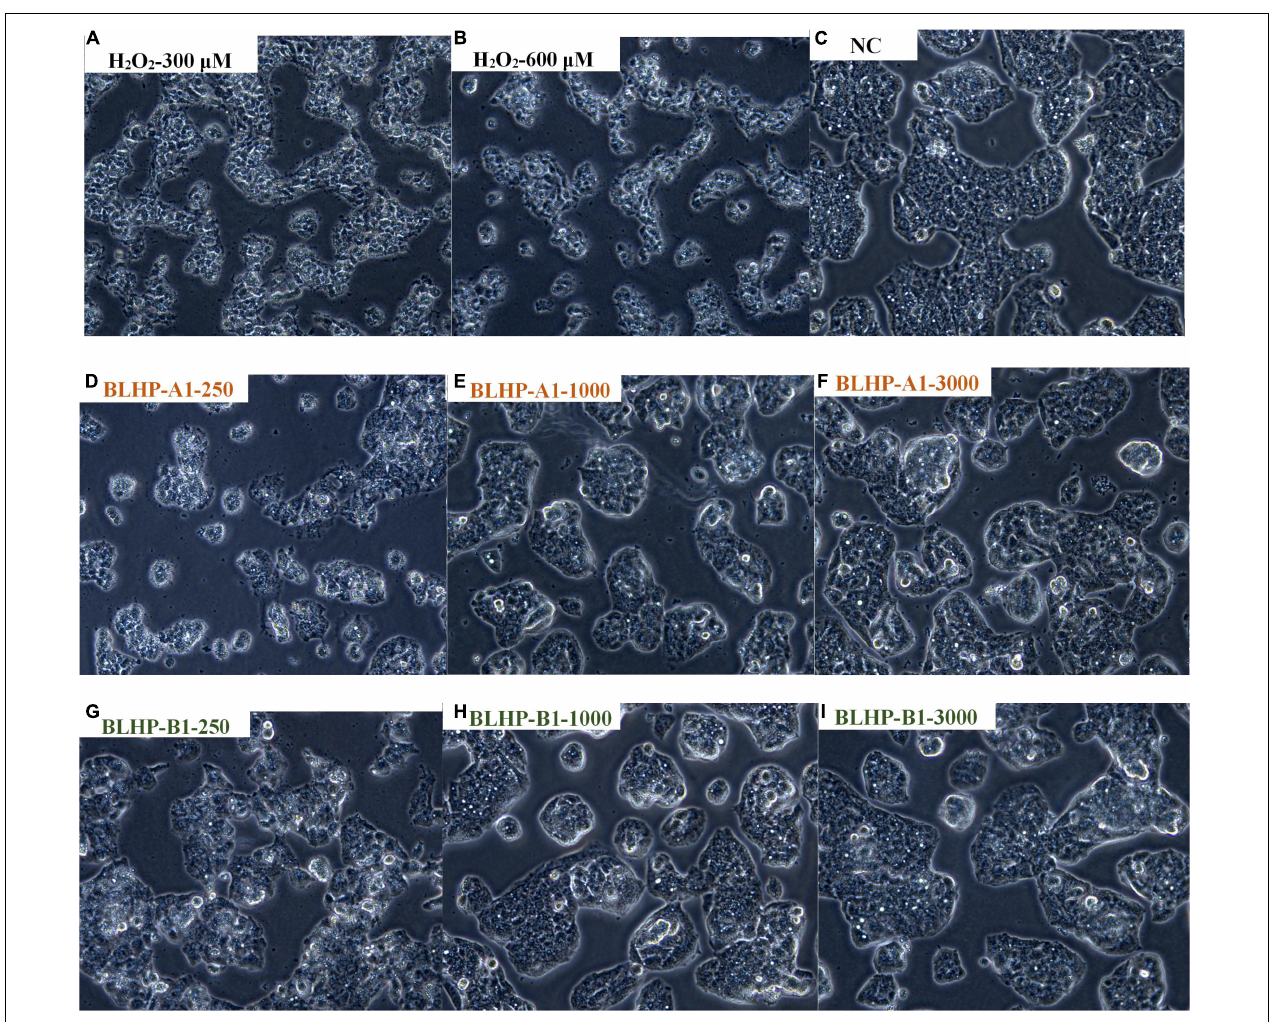
FIGURE 8 | The morphologies of HepG2 cells in different situations. (A,B) Were treated with 300 and 600 µ mol/ml H 2 O 2 , respectively. (C) Represented natural cells in MEM without any treatment or protection. (D–F) Illustrated the protection effects in H 2 O 2 -induced cells by various concentrations (250, 1,000, and 3,000 µ g/ml) of BLHP-A1. (G–I) Indicated the protection effects in H 2 O 2 -induced cells by various concentrations (250, 1,000, and 3,000 µ g/ml) of